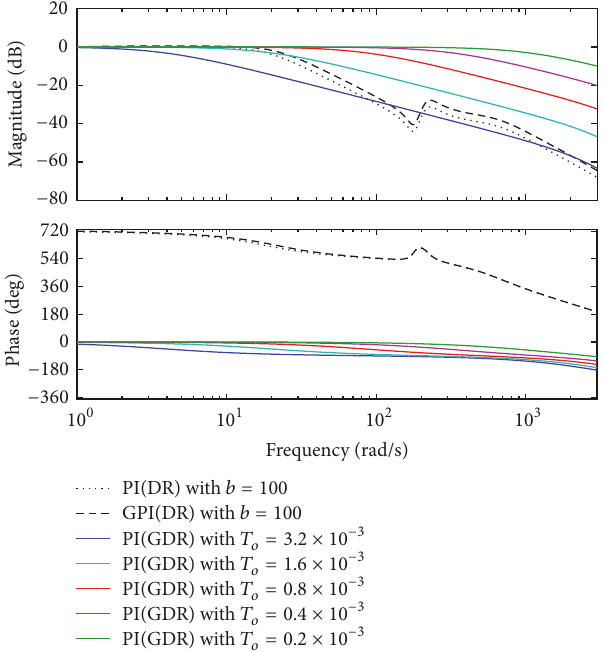
Figure 3: The Bode diagram for PI (DR), GPI (DR), and PI (GDR) observers with different gain